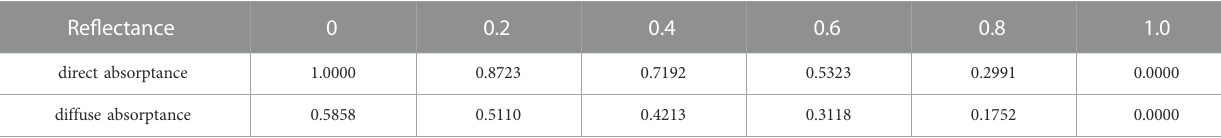
TABLE 6 Summary of direct absorptance and diffuse absorptance, for different re fl ectance of slat surface. Re fl